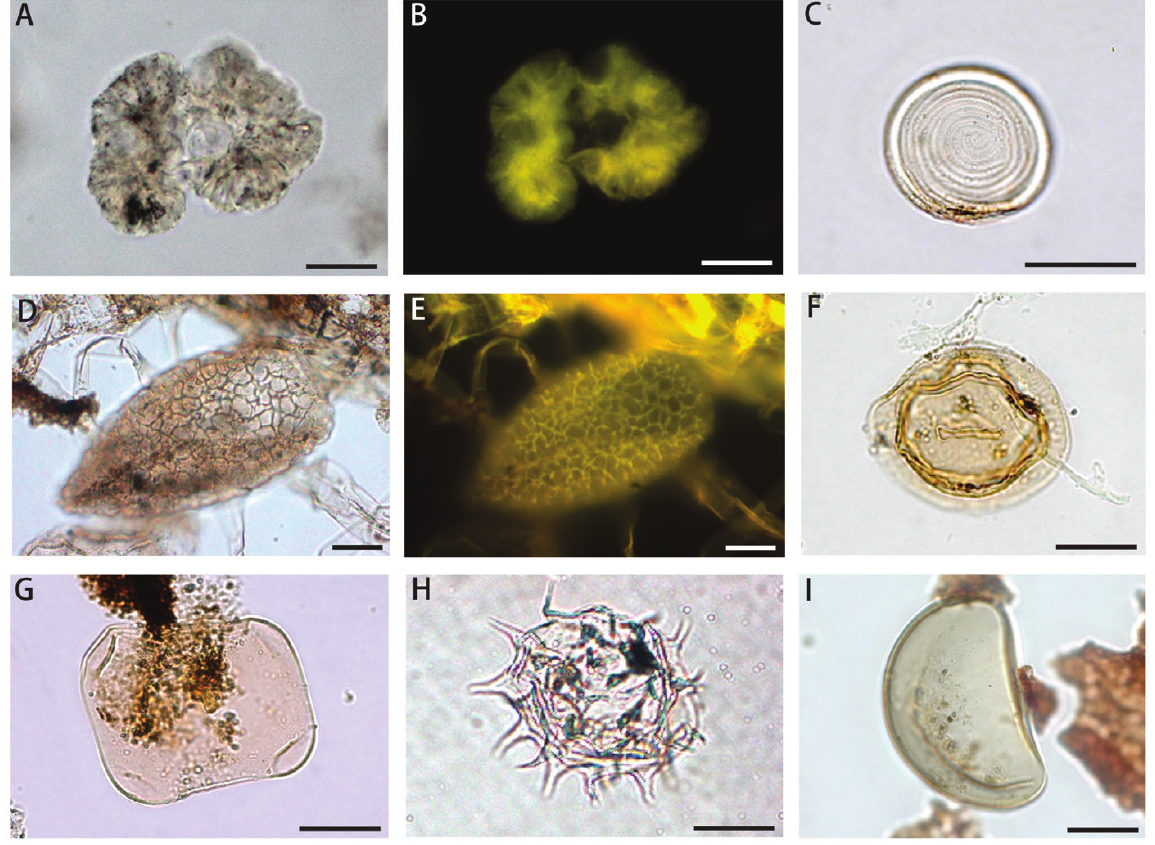
Fig. 4 - Palynomorph group. A-B, Botryococcus ; C, Pseudoschizaea ; D-E, Spyrogira ; F, Debaria ; G, Mougeotia ; H, Desmídia ; I, Pteridophyte spore. Scale bars: 20 µ